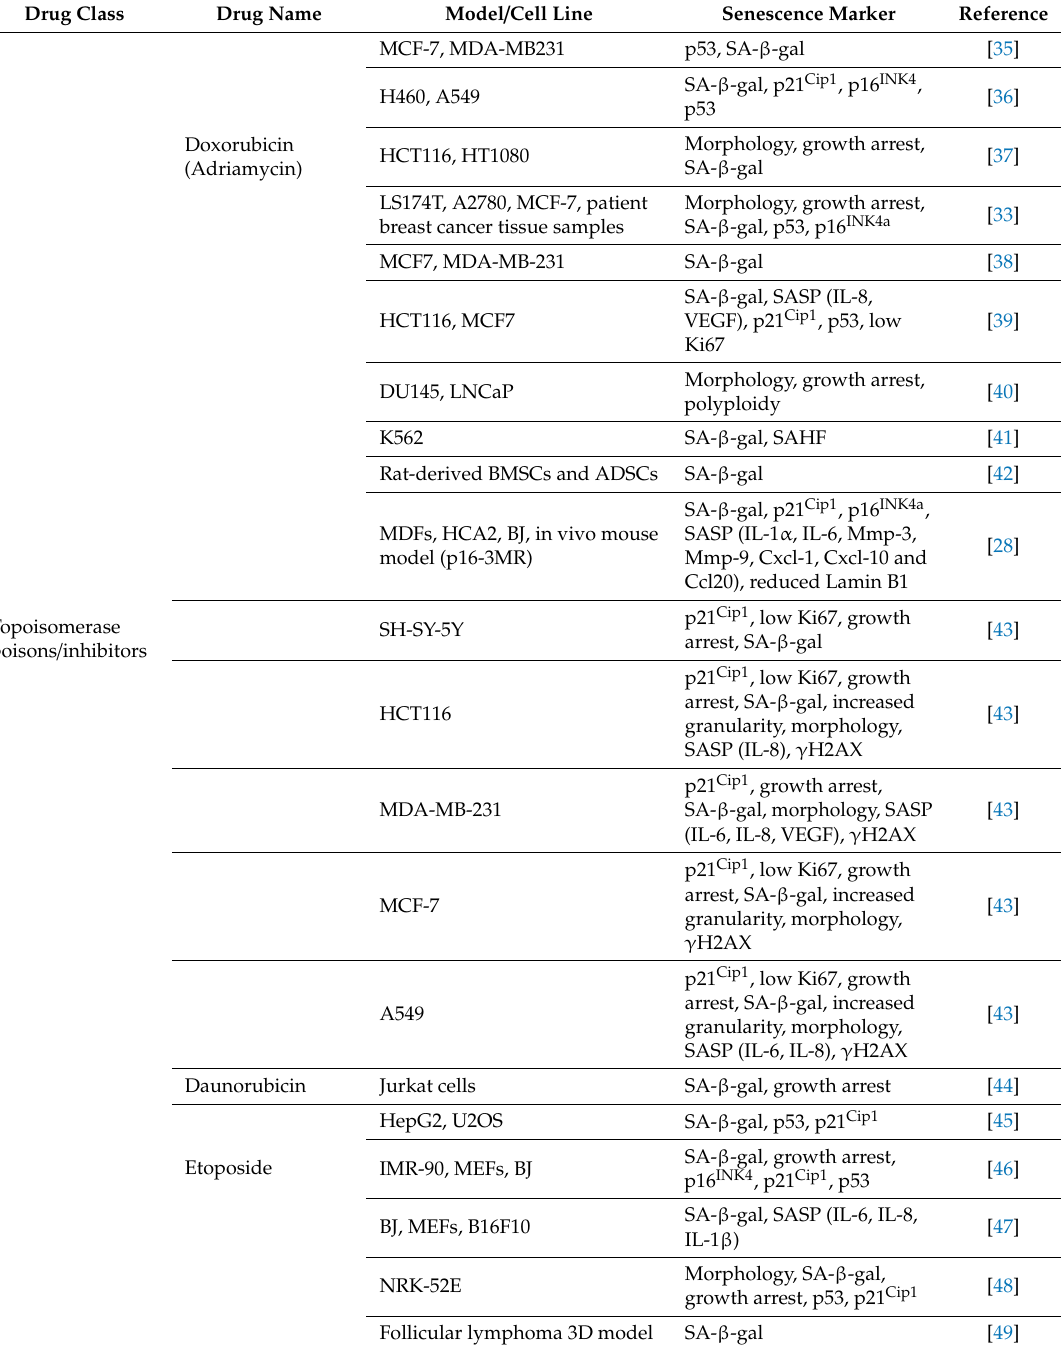
Table 1. FDA-approved anticancer therapies that induce senescence in vitro and in